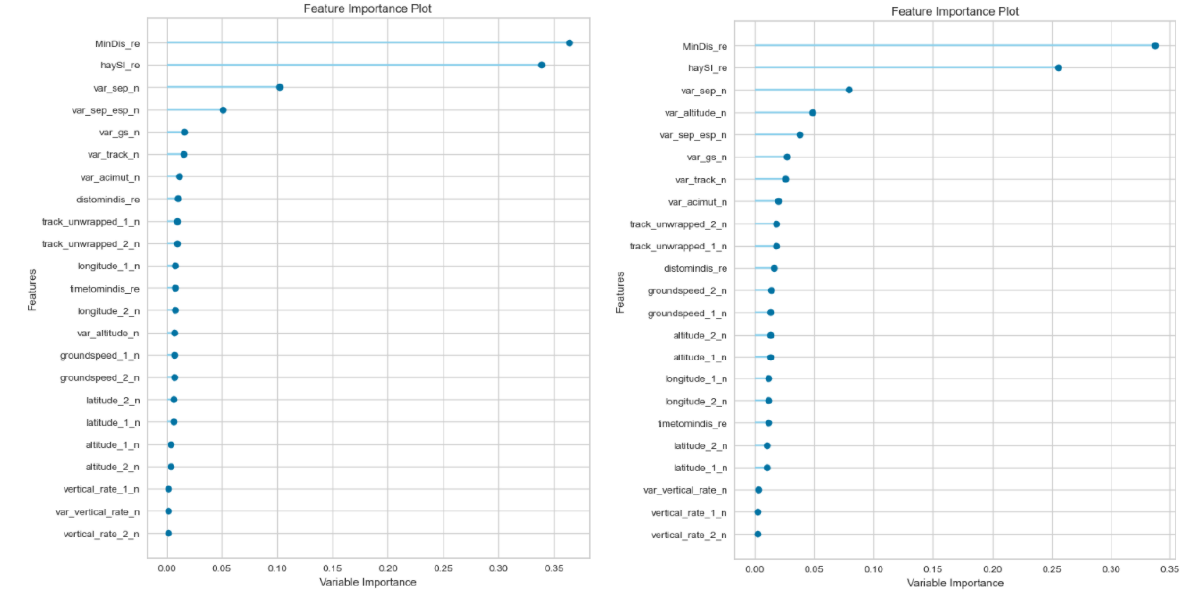
Figure 6. Feature importance of the Pure model (left) and Hybrid model (right) for classification.